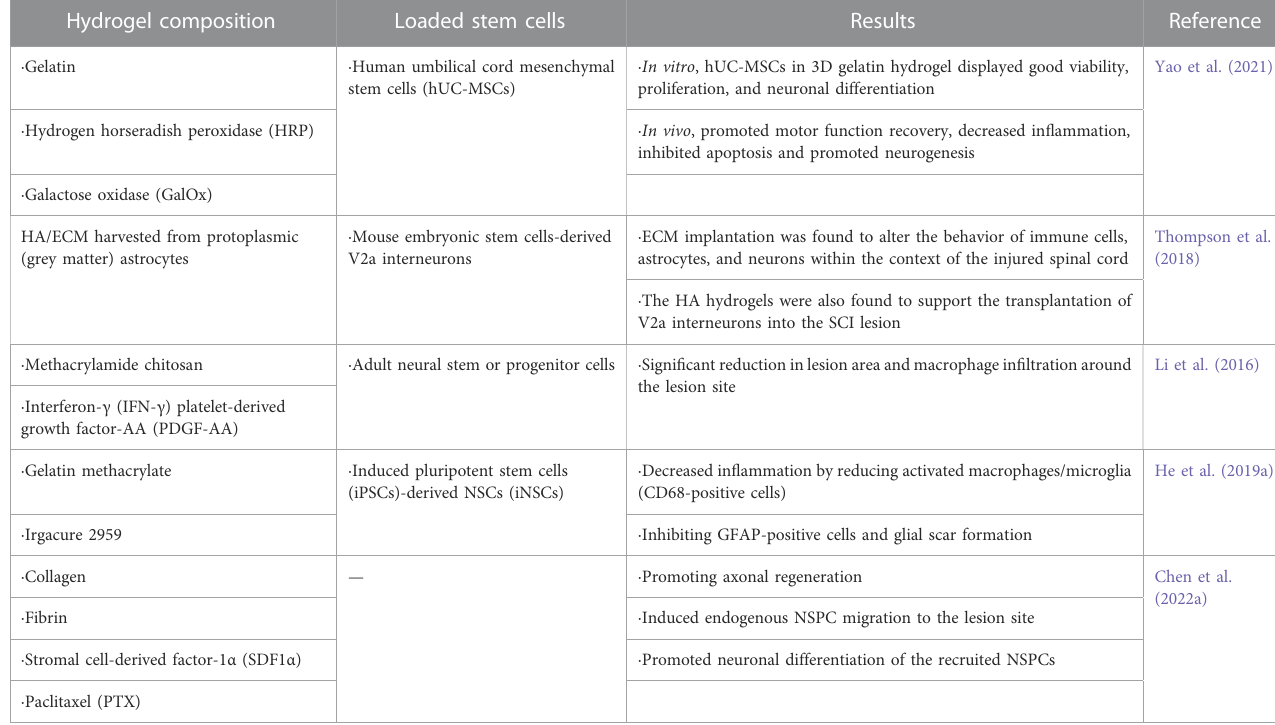
TABLE 1 Some natural hydrogels loaded with stem cells for the treatment of secondary spinal cord injury. Hydrogel composition Loaded stem cells